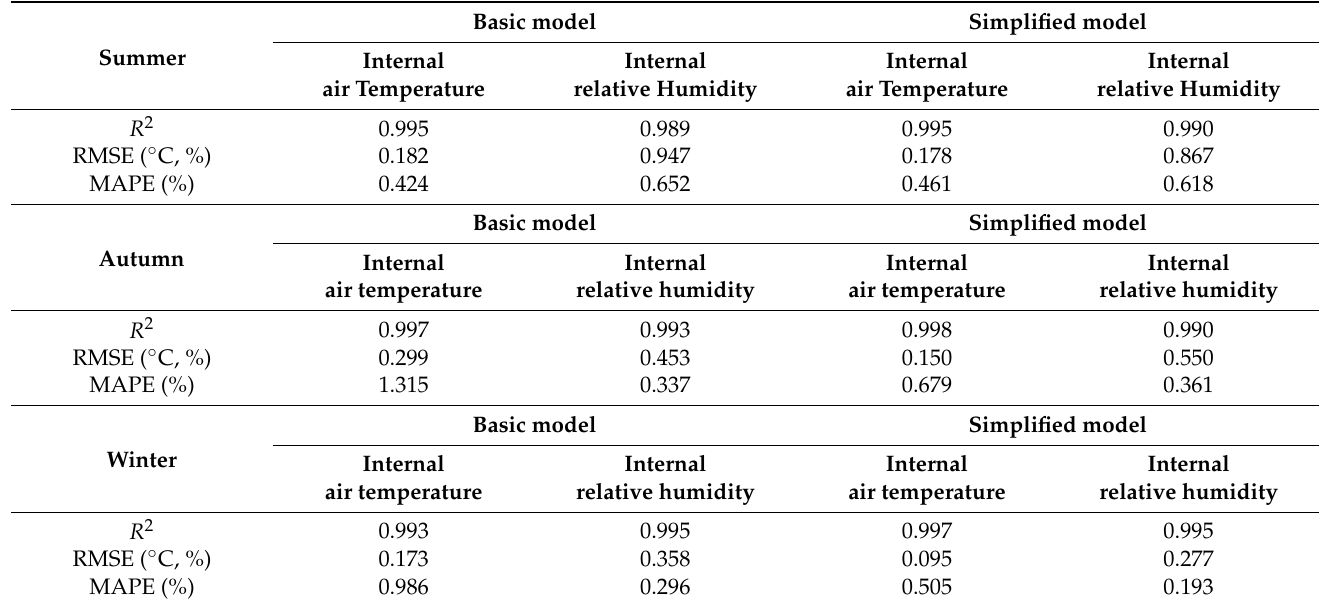
Table 6. Accuracy of RNN model of mechanically ventilated duck house according to seasons and variables (sequential order).